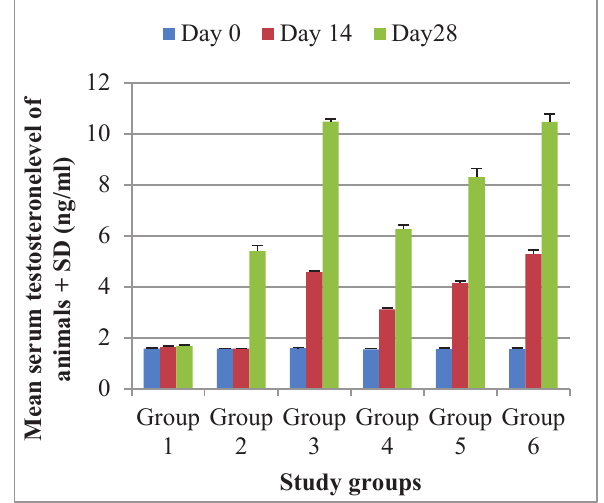
Fig-1: Cluster bar diagram presenting mean serum testosterone levels for six study groups (error bars presenting standard deviation)